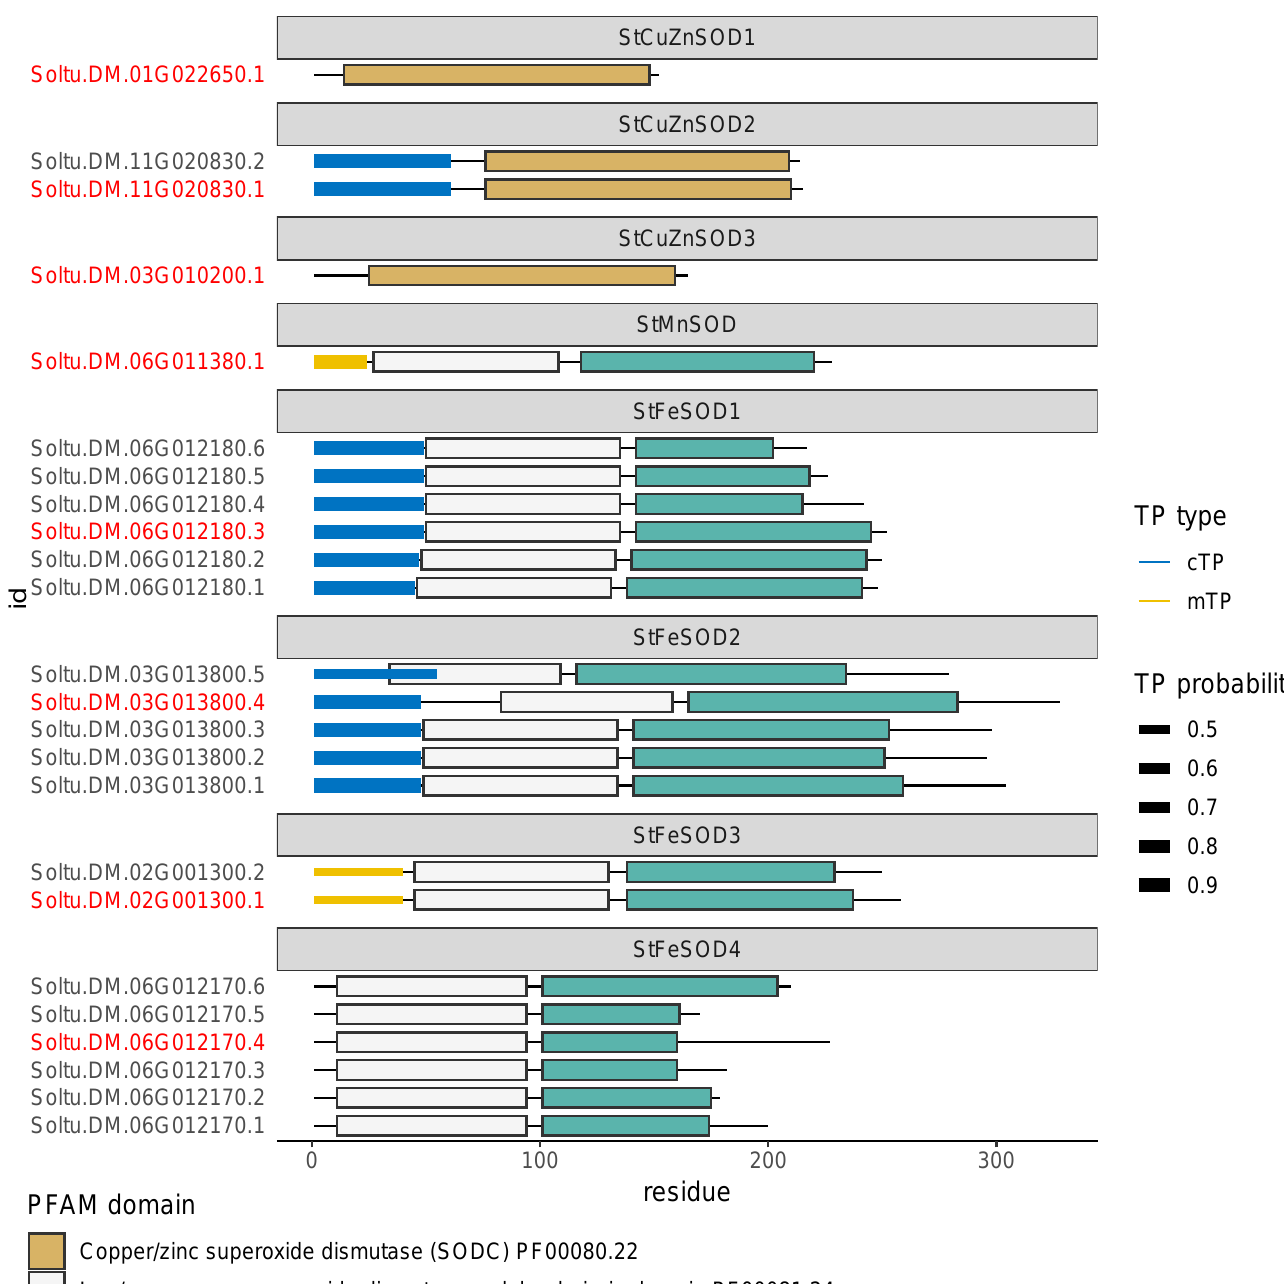
Figure 3. Annotation of protein sequences encoded by StStSOD genes. Protein sequences from all gene models are shown; protein products from representative (according to Spud DB DM v6.1 annotation) gene models are highlighted in red. Pfam domains are indicated by the color